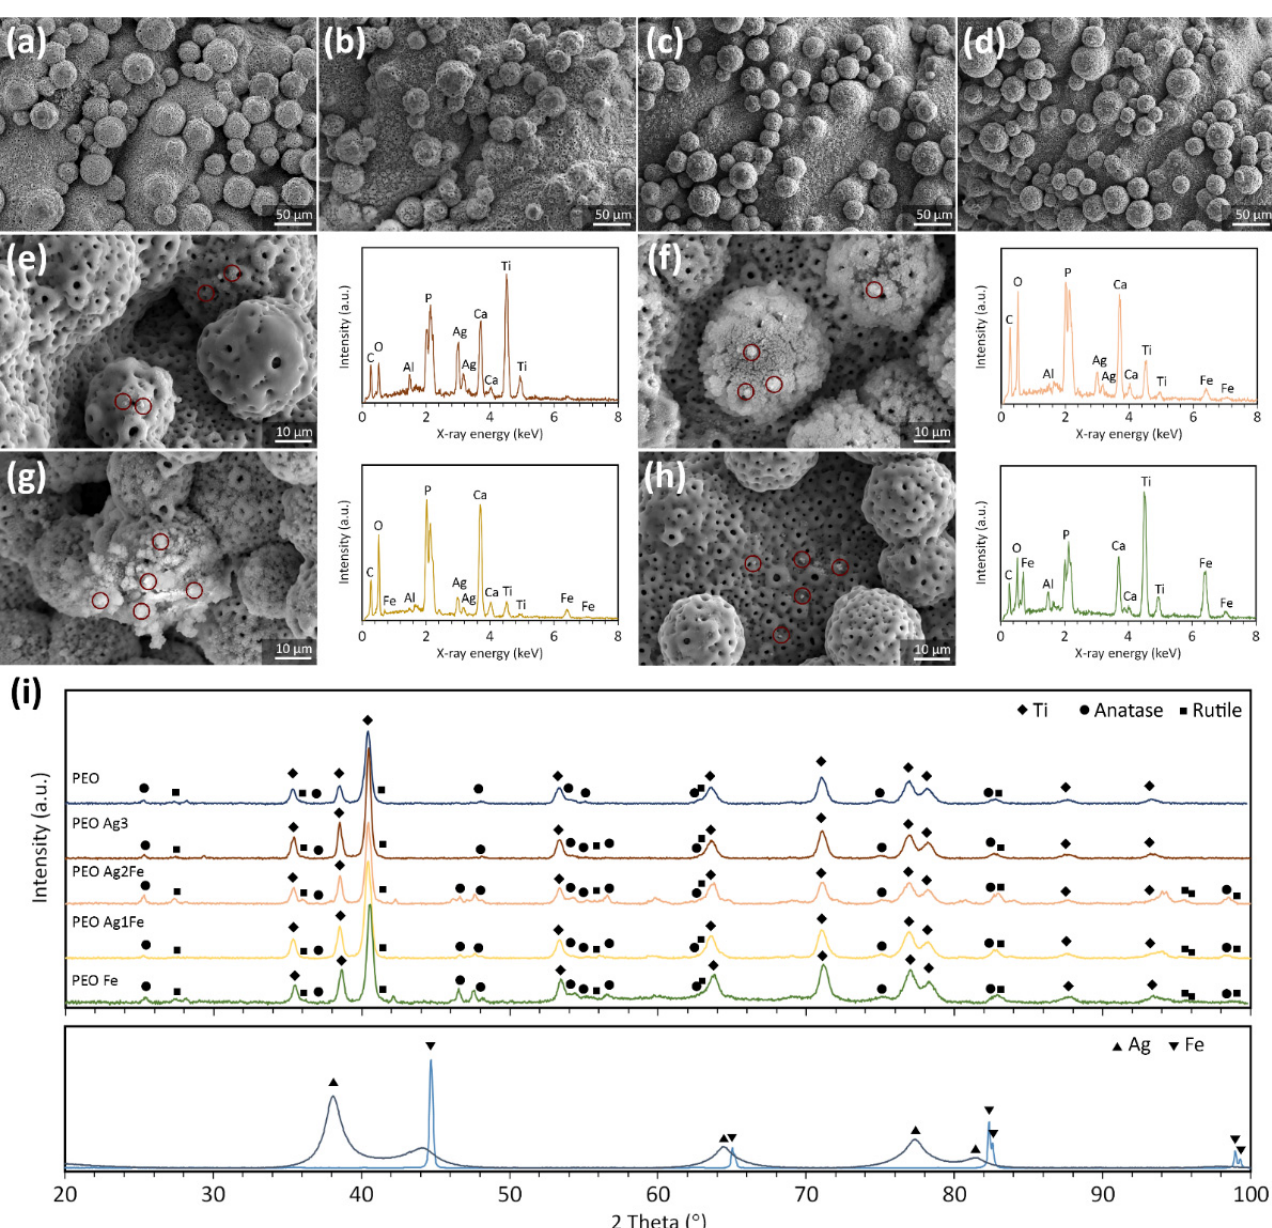
Figure 2. The surface morphology of ( a ) PEO Ag3, ( b ) PEO Ag2Fe, ( c ) PEO Ag1Fe, and ( d ) PEO Fe scaffold groups after 180 s of surface biofunctionalization, imaged using SEM. The chemical compositions of the biofunctionalized scaffolds containing Ag and/or Fe NPs: ( e ) PEO Ag3, ( f ) PEO Ag2Fe, ( g ) PEO Ag1Fe, and ( h ) PEO Fe. The circles indicate the locations of EDS analysis. ( i ) The phase compositions of the biofunctionalized scaffolds and Ag and Fe NPs.